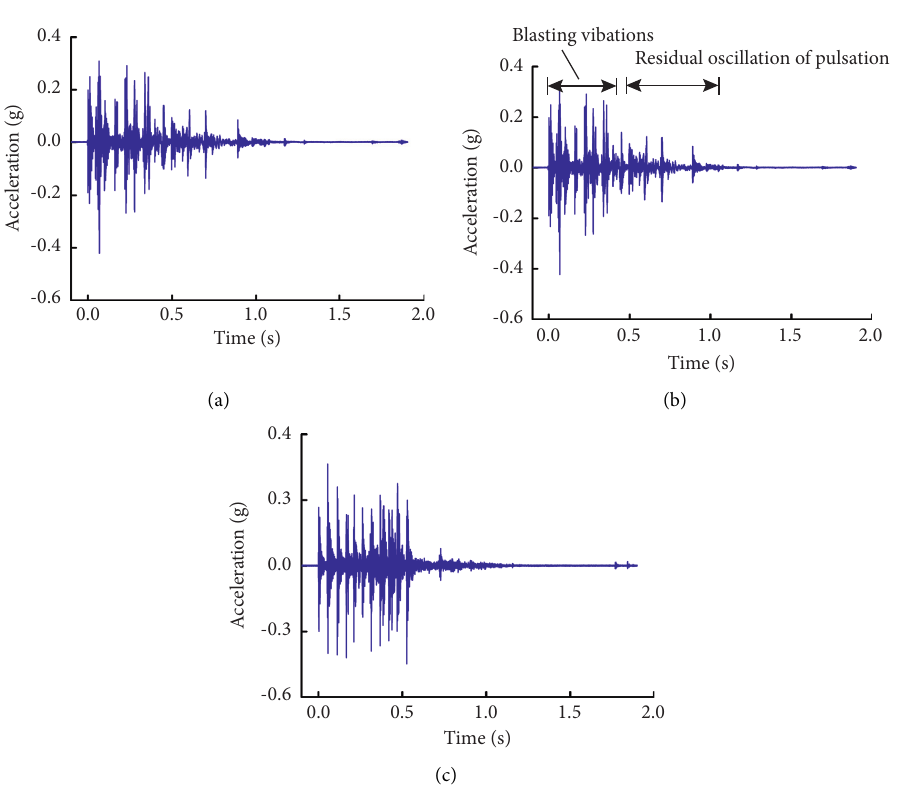
Figure 7: Acceleration waveform of blasting vibrations, (a) acceleration waveform of the first blasting, (b) acceleration waveform of the second blasting, and (c) acceleration waveform of the third